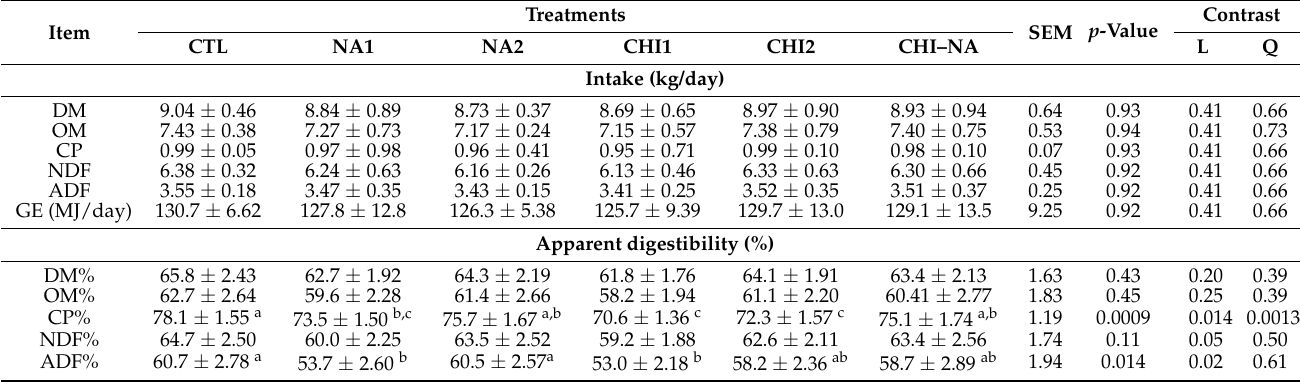
Table 4. Effect of naringin and chitosan supplementation at different levels on feed intake and digestibility in heifers.